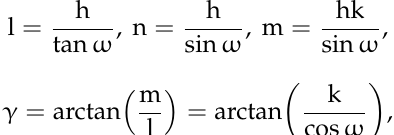
Figure 10. Localization error caused by roll, pitch, and yaw error. ( a ) The relationship between the horizontal FOV of the camera θ , the pitch angle of the camera ω , the height of the UAV h , and other variables. ( b ) The target localization error δ x caused by the roll and yaw error δγ . ( c ) the target localization error δy caused by the pitch angle error.